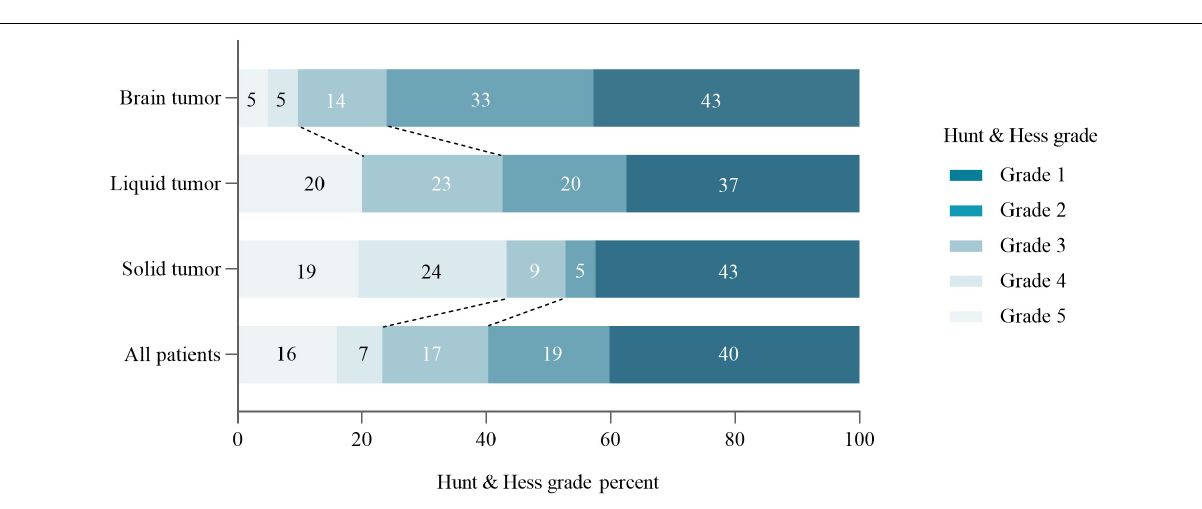
FIGURE 4 | Stacked bars of Hunt and Hess grade in cancer patients at the onset of